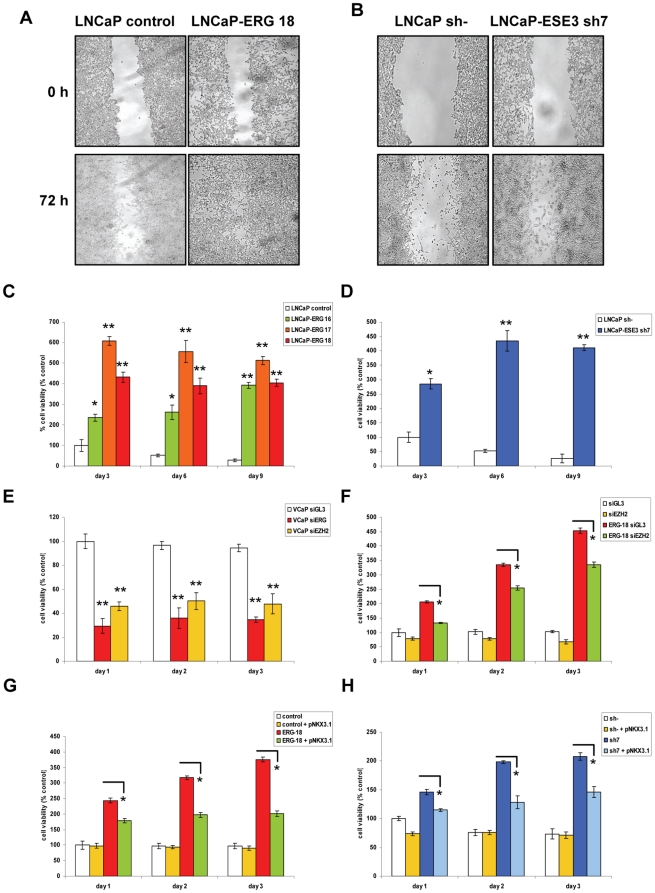
Effects of deregulated expression of ERG and ESE3 in prostate cancer cells.
A. ERG over-expression and ESE3 knock-down (B) enhance cell migration. Cells were grown until confluence and starved for 24 h when a scratch was performed on the monolayer. Pictures were taken at 0 and 72 h. Representative photographs of triplicate experiments are shown. C. Control and ERG over-expressing LNCaP cell clones were plated in polyhema coated 96-well plates and cell viability was measured using a colorimetric assay at the indicated time points. D. Control and ESE3 knock-down LNCaP cells were plated in polyhema and assayed as described above. E. VCaP cells were transfected with siRNAs against ERG or EZH2 and plated in polyhema after 24 h. Cell viability was measured as described above. F. Parental and ERG-expressing (ERG-18) LNCaP cells were transfected with siRNAs against EZH2 and assayed as indicated above. G. Parental and ERG-expressing (ERG-18) LNCaP cells were transfected with full length Nkx3.1 expression vector and assayed as indicated above. H. Parental (sh-) and ESE3 knock-down (sh-7) LNCaP cells were transfected with full length Nkx3.1 expression vector and assayed as indicated above. Data are presented as mean ± SD of triplicate experiments. *, p<0.01; **, p<0.001.